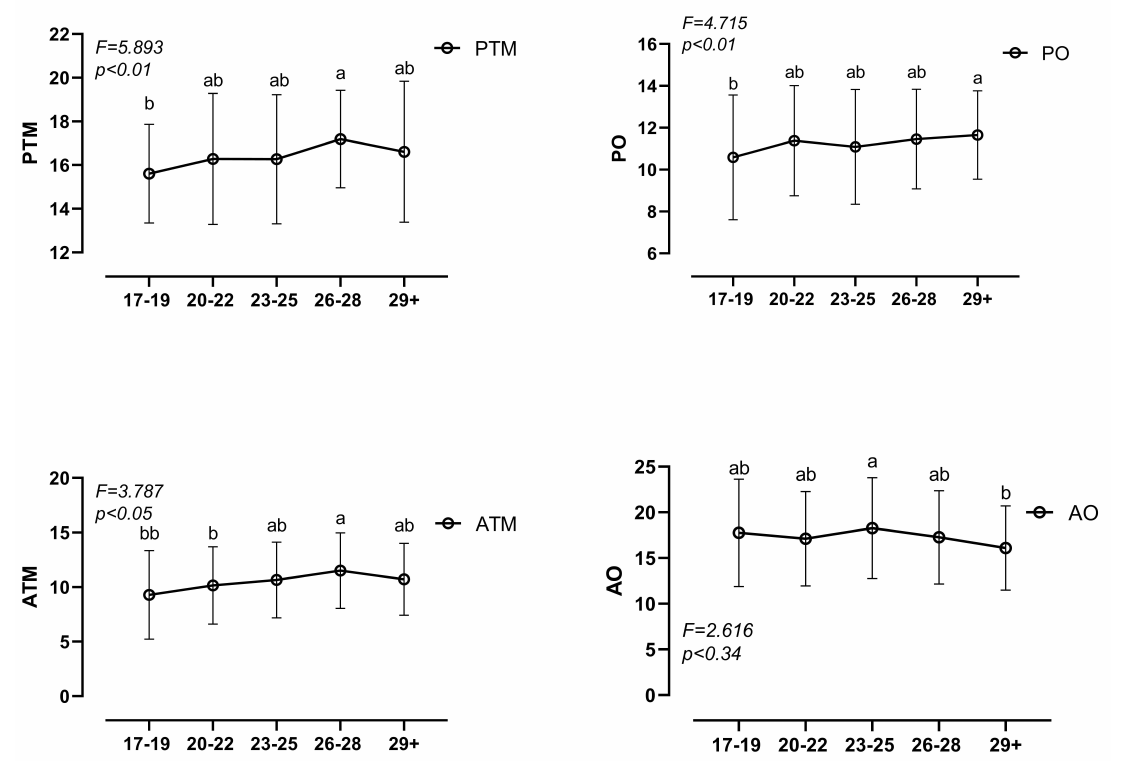
Fig. 3. Comparisons of PABSS’ subdimensions according to football players’ age groups . Values are expressed as mean and standard deviation; F results of One-Way ANOVA; ab Results of Tukey HSD; p < 0.01. p values, 95% confidence interval; PTM, Prosocial teammate; PO, Prosocial opponent; ATM, Antisocial teammate; AO, Antisocial